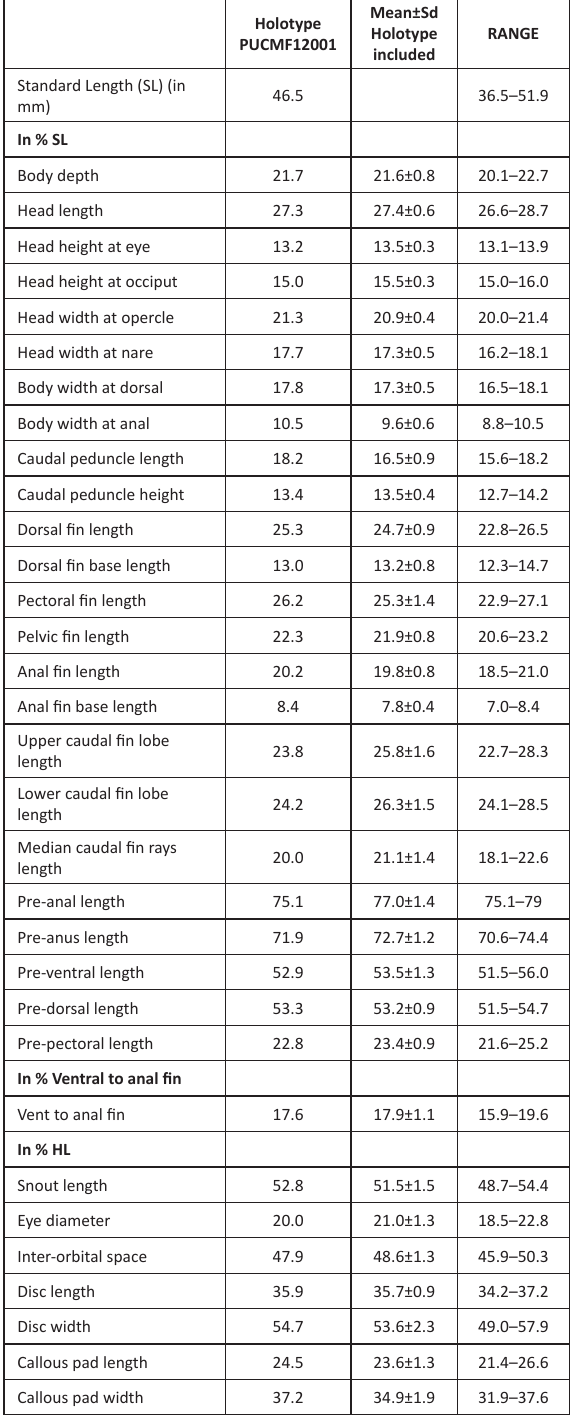
Table 1. Biometric data for Garra dampaensis sp. nov. (n=16). All ratios expressed as percent of sL, hL, or ventral-anal length.